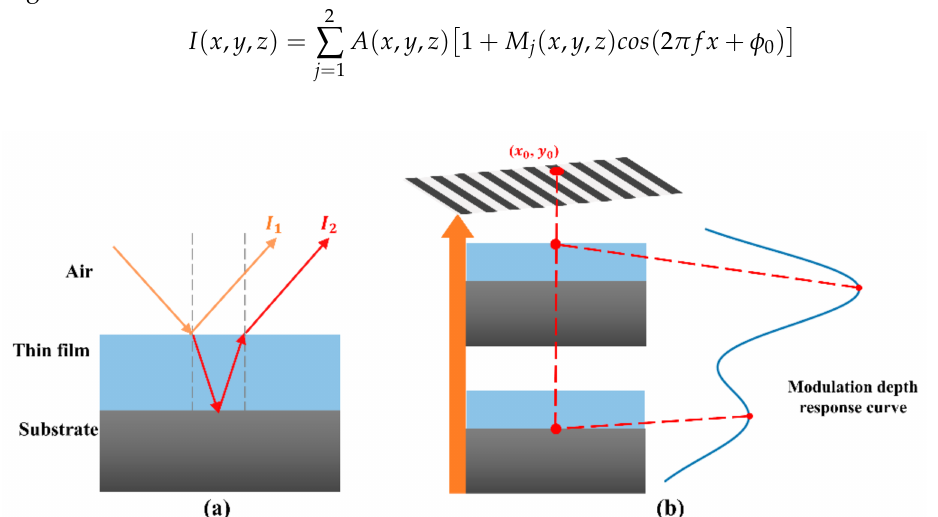
Figure 2. Principle of surface and thickness measurement: ( a ) the incoherent model of light reflection in a single-layered film structure; ( b ) the simulated modulation depth response (MDR) for a pixel ( x ) generated during the z -axis 0 , y 0